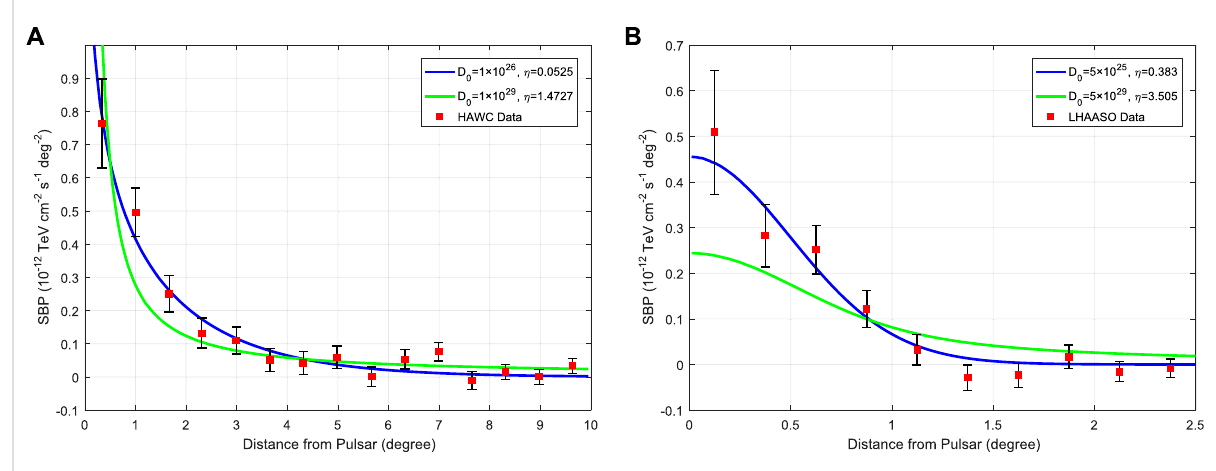
FIGURE 3 Gamma-raypro fi lesoftheGemingahalo (A) andLHAASOJ0621+3755 (B) aftertherelativisticcorrectiontothepropagationequation,forboth thefast- and slow-diffusion scenarios. D 0 isthediffusion coeffcientat1 GeV,and η istheconversionef fi ciency fromthe pulsarspin-down energyto the electron injection energy. Both fi gures are taken from Bao et al.